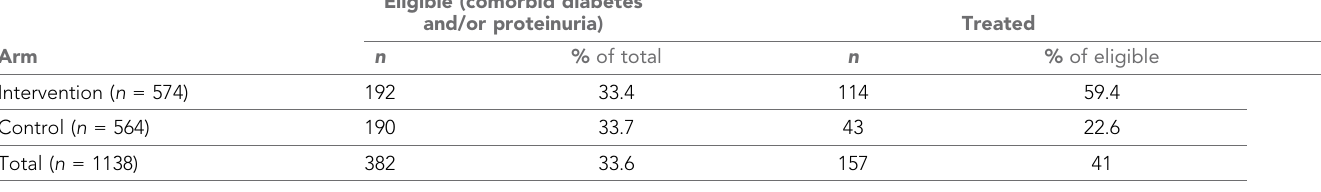
Eligible (comorbid diabetes and/or